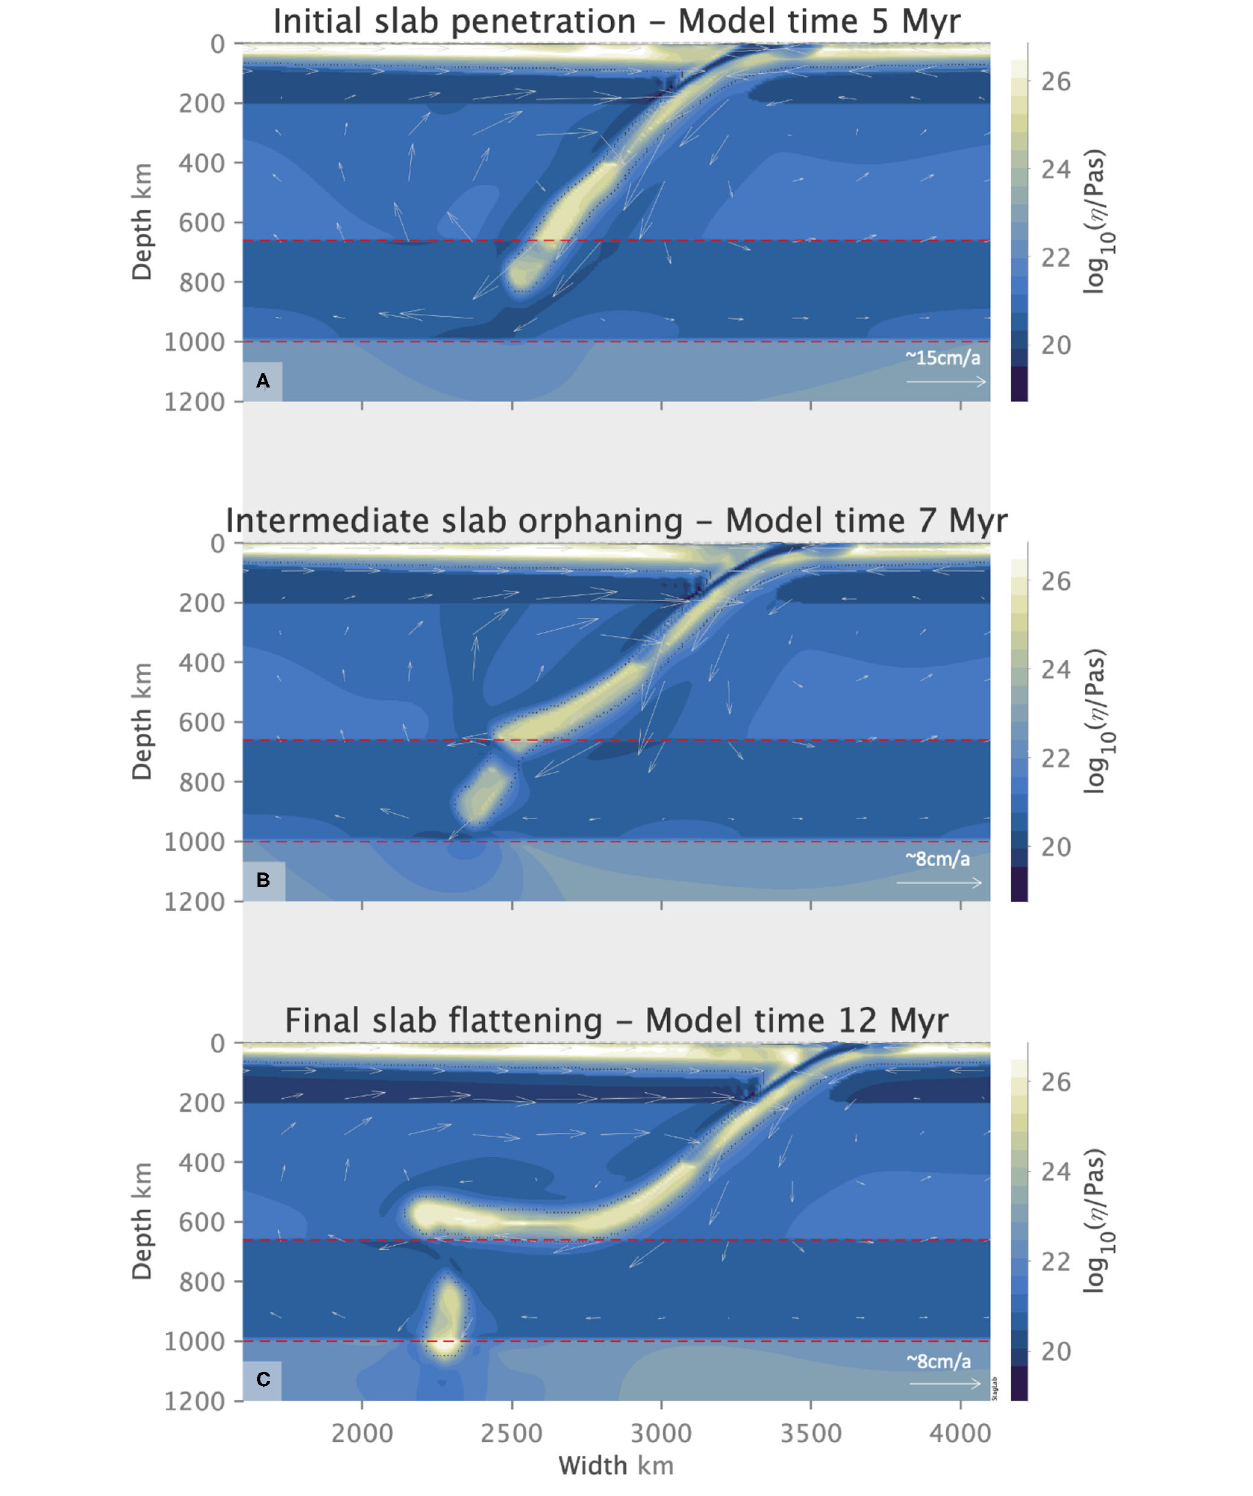
FIGURE 9 | A slab with yield stress of 600 MPa transitions from an initial penetrative behavior (A) to a flattened morphology (C) through orphaning (B) , showing how orphaning allows a slab to mode switch and transition from one morphology to the other. Flow arrows indicate the sense of flow direction and its relative magnitude for each